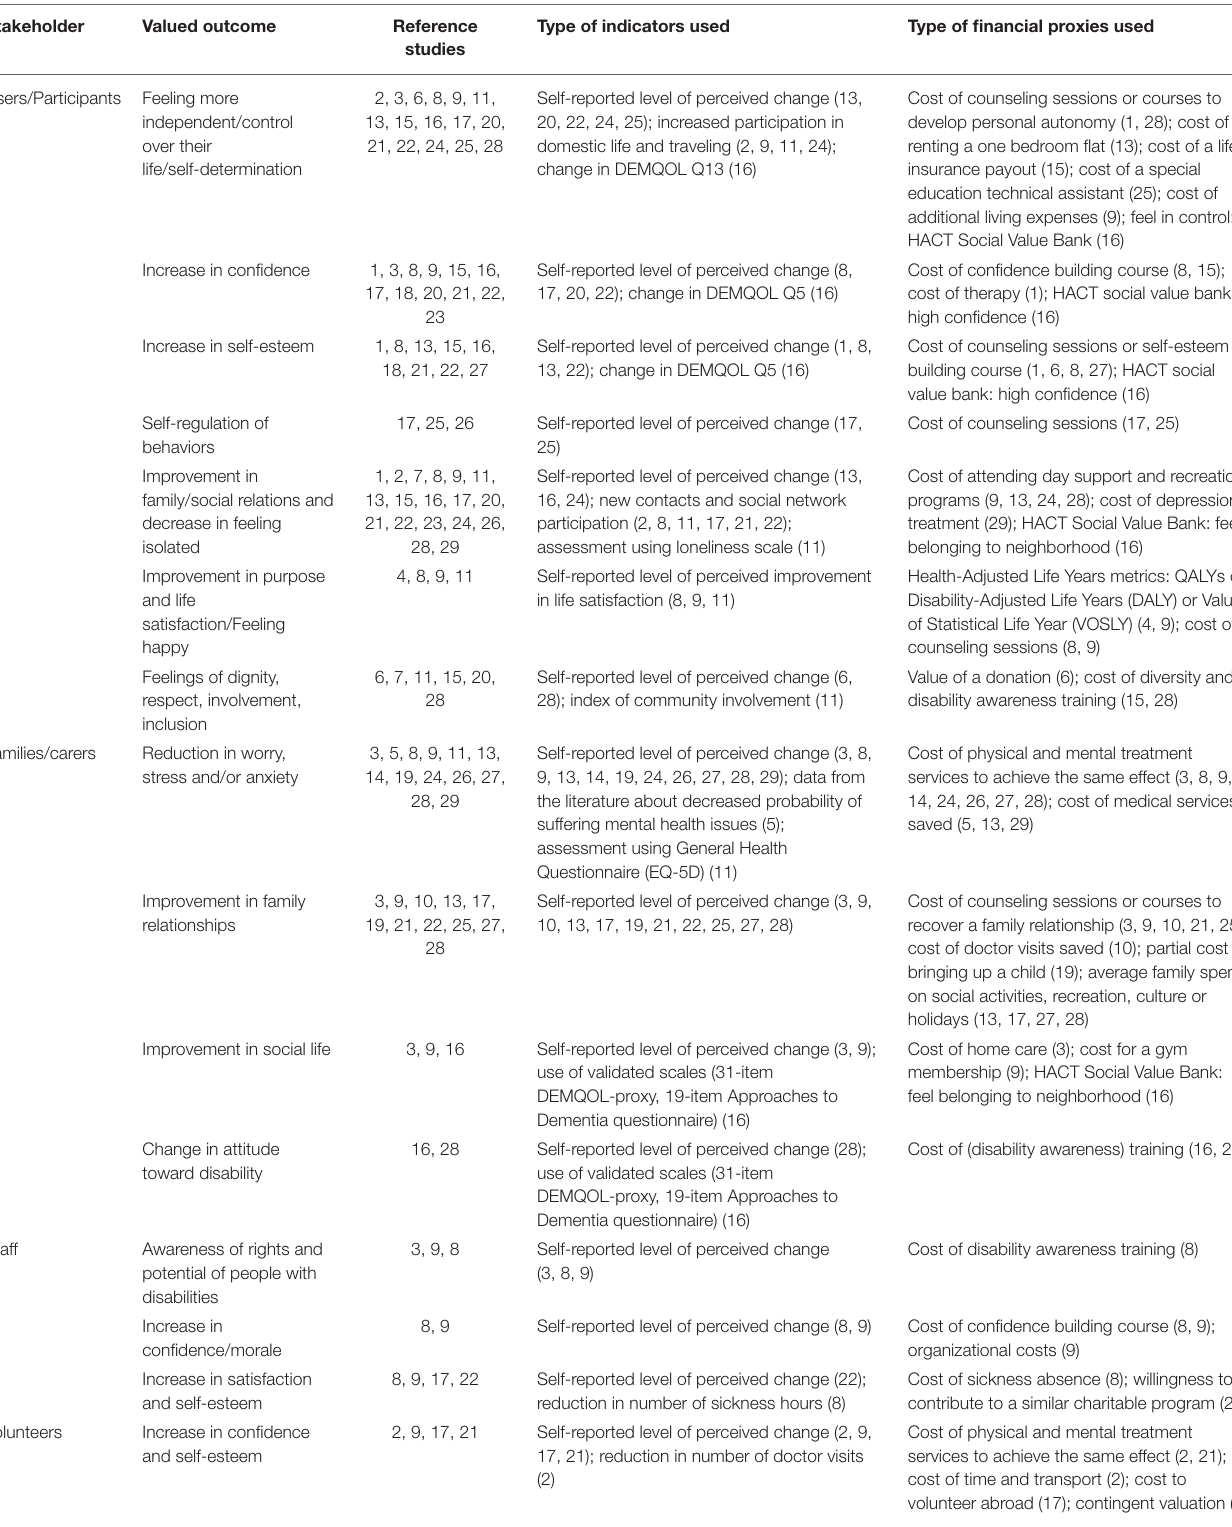
Type of indicators used Type of financial proxies used studies